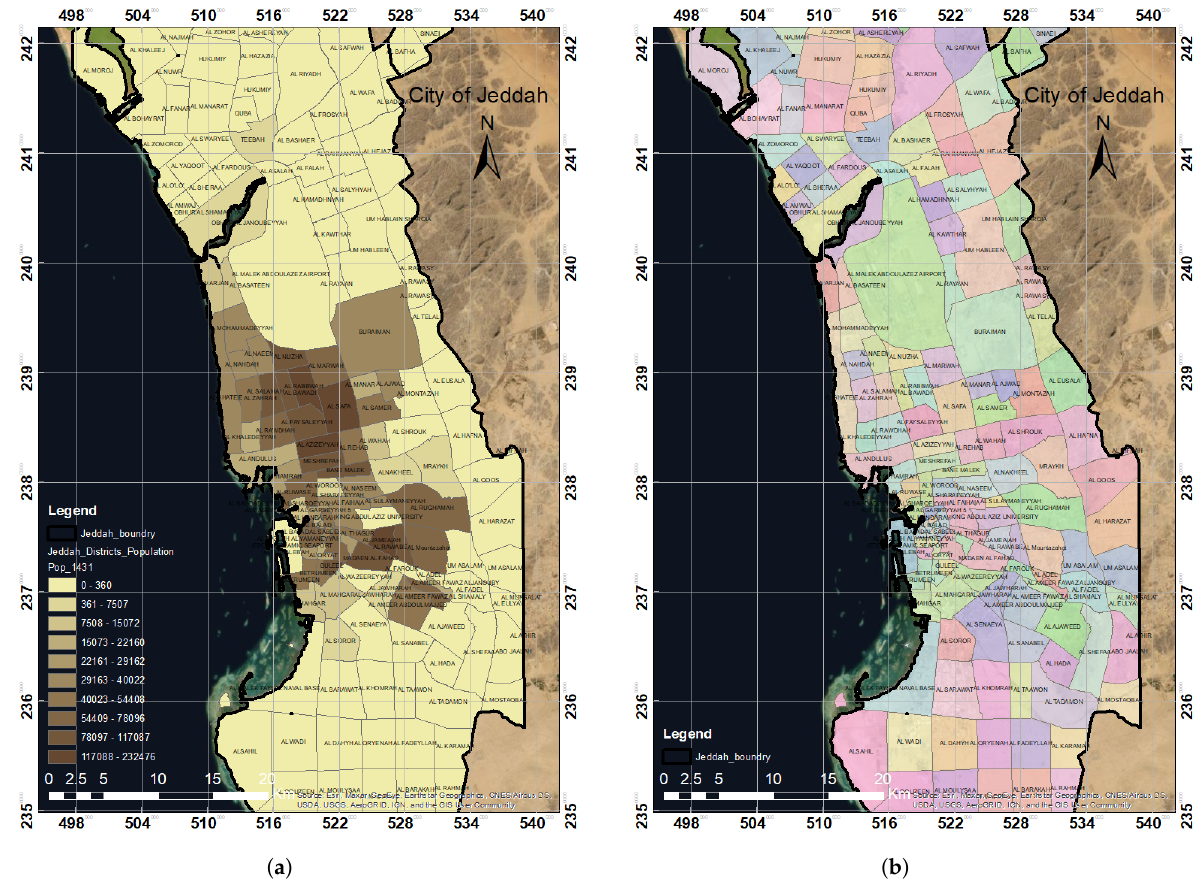
Figure 6. The spatial distribution of the population in Jeddah by district ( a ) and a map of districts in the city of Jeddah ( b ). ( a ) Population distribution map. ( b ) District distribution